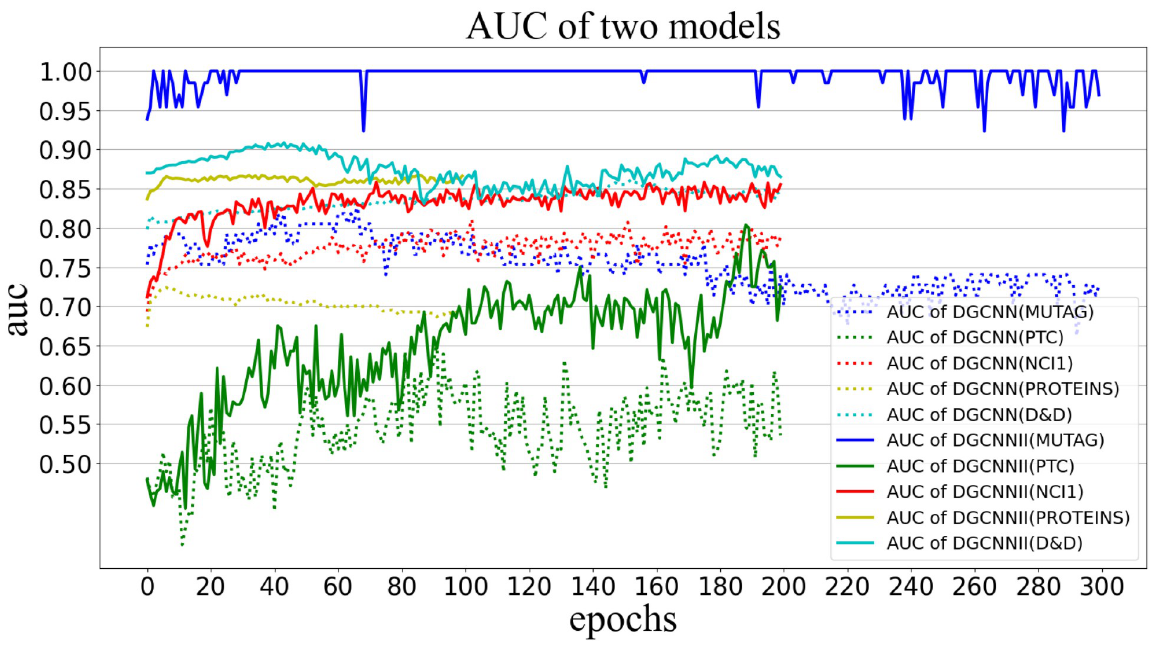
Fig 10. AUC values of DGCNNII and DGCNN on 5 test